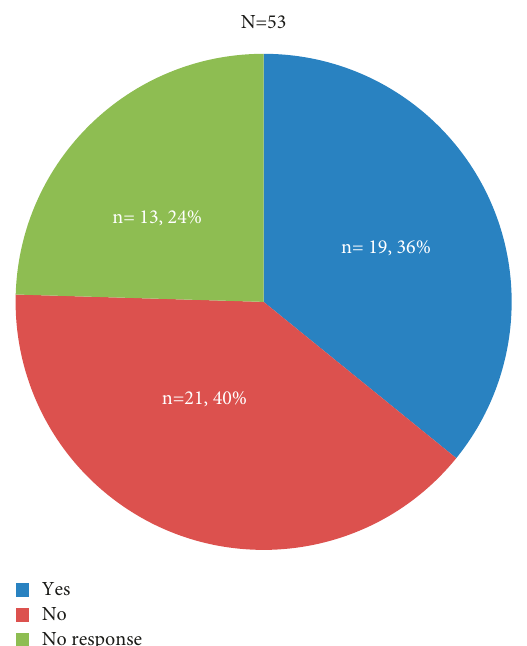
Figure 5: Effectiveness of mitigation methods applied so